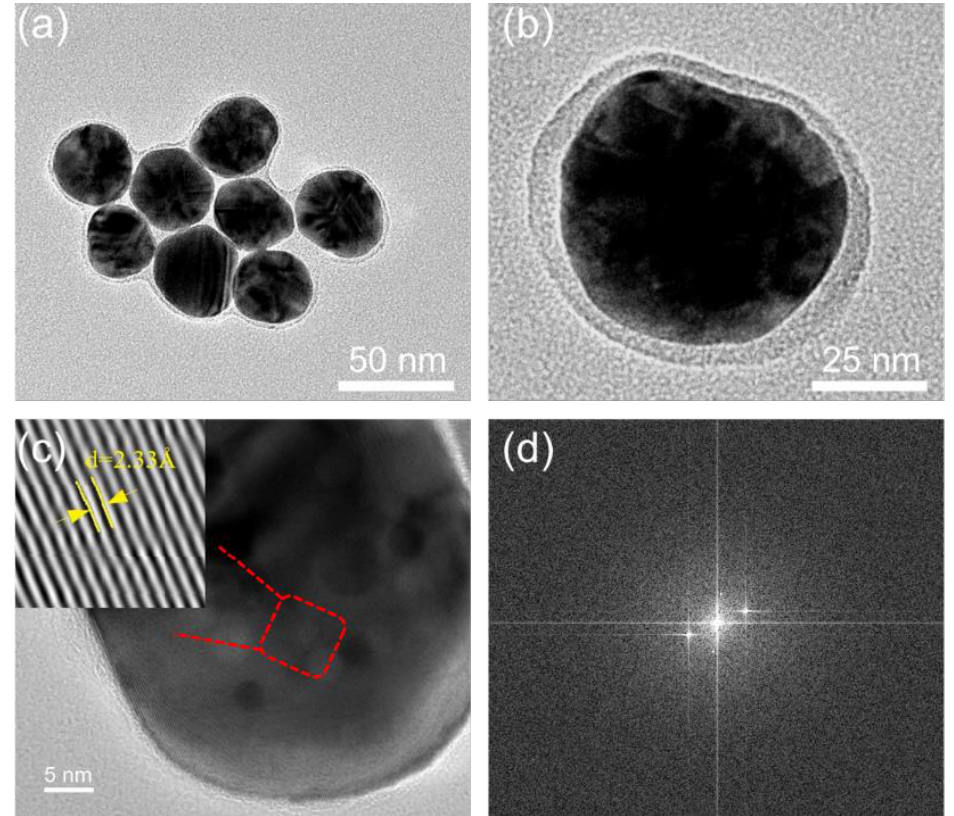
Figure 2. TEM images of Ag@QCNPs. ( a ) Ag@QCNPs and ( b ) single particle; ( c ) High resolution TEM image of Ag@QCNPs. Inset is from the red line area and shows crystallite pattern of the core with a lattice spacing of 2.33 Å ; ( d ) Fast Fourier transform of high-resolution TEM.